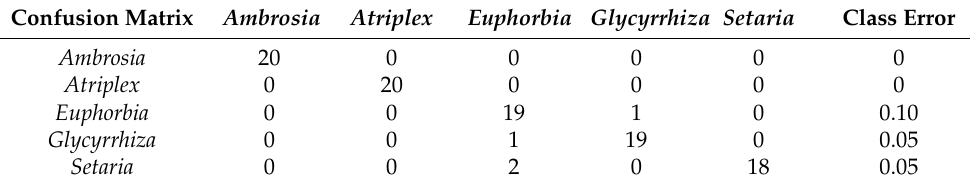
Table 16. Confusion matrix for weed identification by D1, Datt3, and